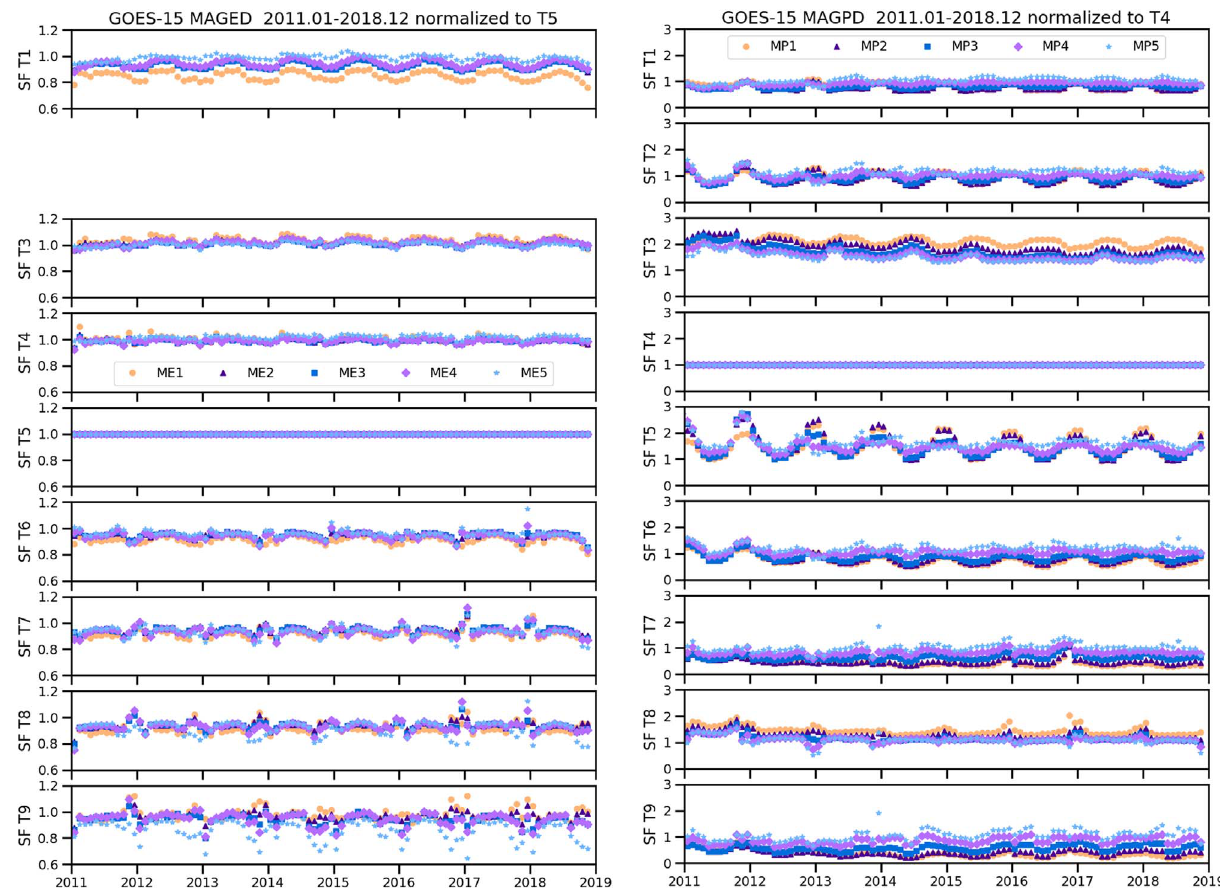
Fig. 8. Intra-calibration scale factors (SFs, unitless) for GOES-15 MAGED (left) and MAGPD (right), 2011 – 2018. Each panel illustrates the SFs for all fi ve energy channels from one telescope. MAGED T2 was omitted due to severe noise.